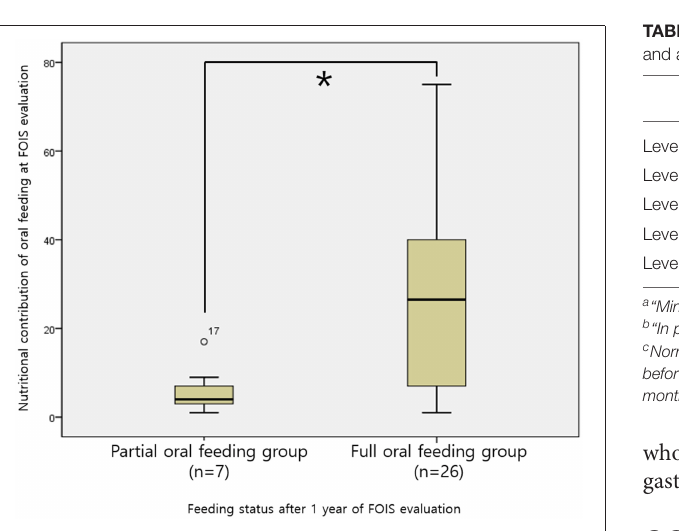
FIGURE 2 | Comparison of the caloric contributions of oral intake among POF infants stratified according to the achievement or non-achievement of FOF after 1 year * p < 0.001. POF, partial oral feeding; FOF, full oral feeding.